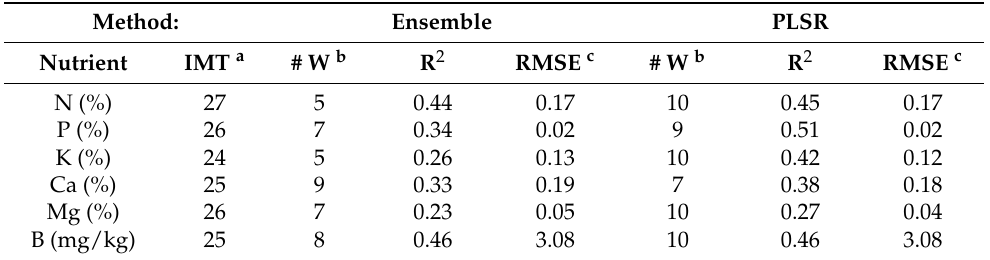
Table 1. Grapevine leaf nutrient LOOCV, adjusted R 2 , and RMSE for the ensemble and PLSR methods.